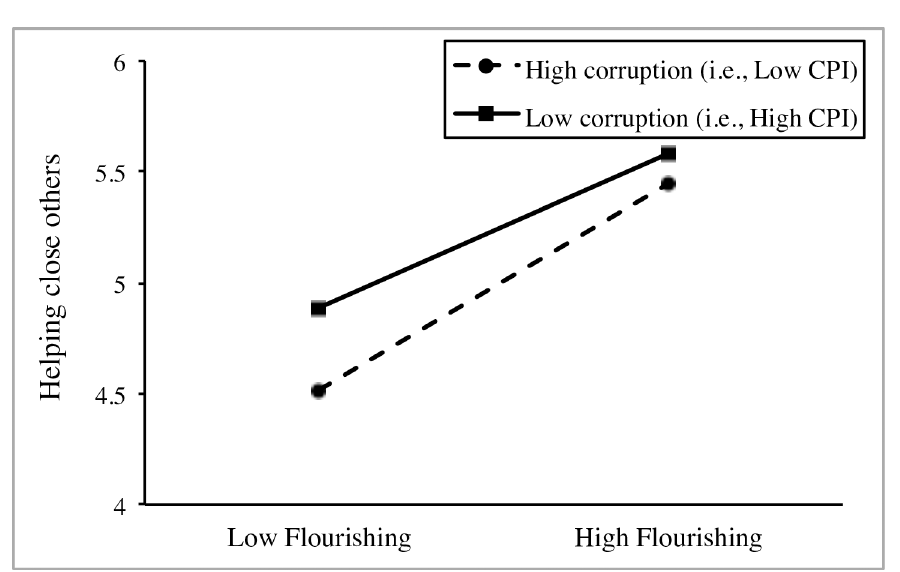
Fig 4. Cross-level interaction between flourishing and CPI on helping close others in Study